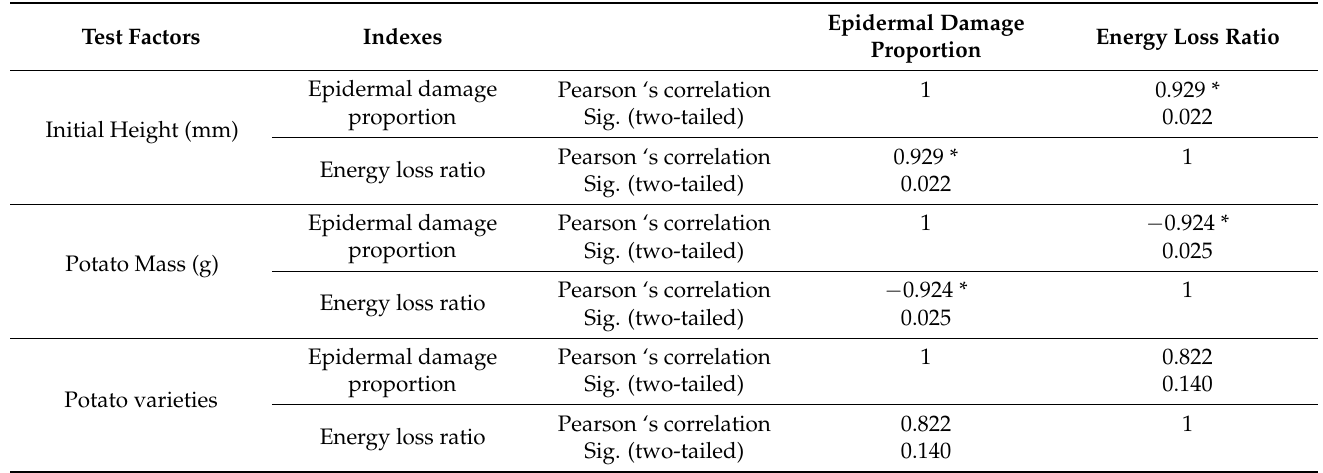
Table 5. Correlation coefficients and significant results of epidermal damage proportion and energy consumption loss ratio.